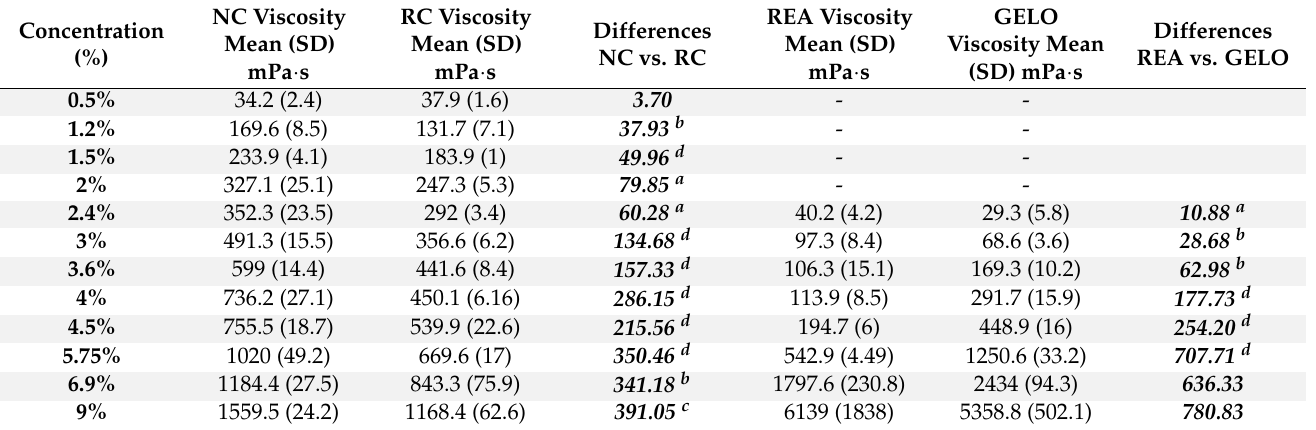
Table 2. Average viscosity of the four thickeners at a 50 s − 1 shear rate and comparisons